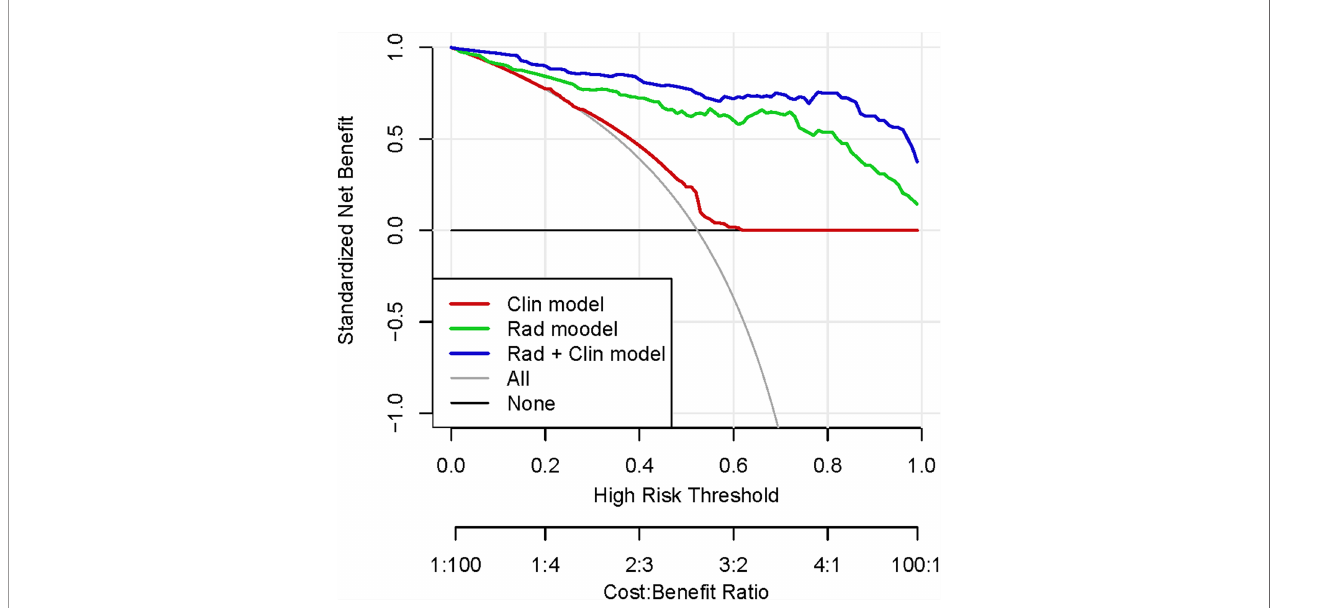
FIGURE 4 | Decision curve analysis (DCA) for each model (clinical model, radiomic model, and integrated Rad+Clin model). The integrated Rad+Clin model had the highest net bene fi t in predicting which high-risk patients should receive more aggressive treatment, as compared with radiomic model, a clinical model, and simple strategies such as to treat all patients or no patients. This analysis was performed across the full range of threshold probabilities at which a patient would be selected to undergo follow-up